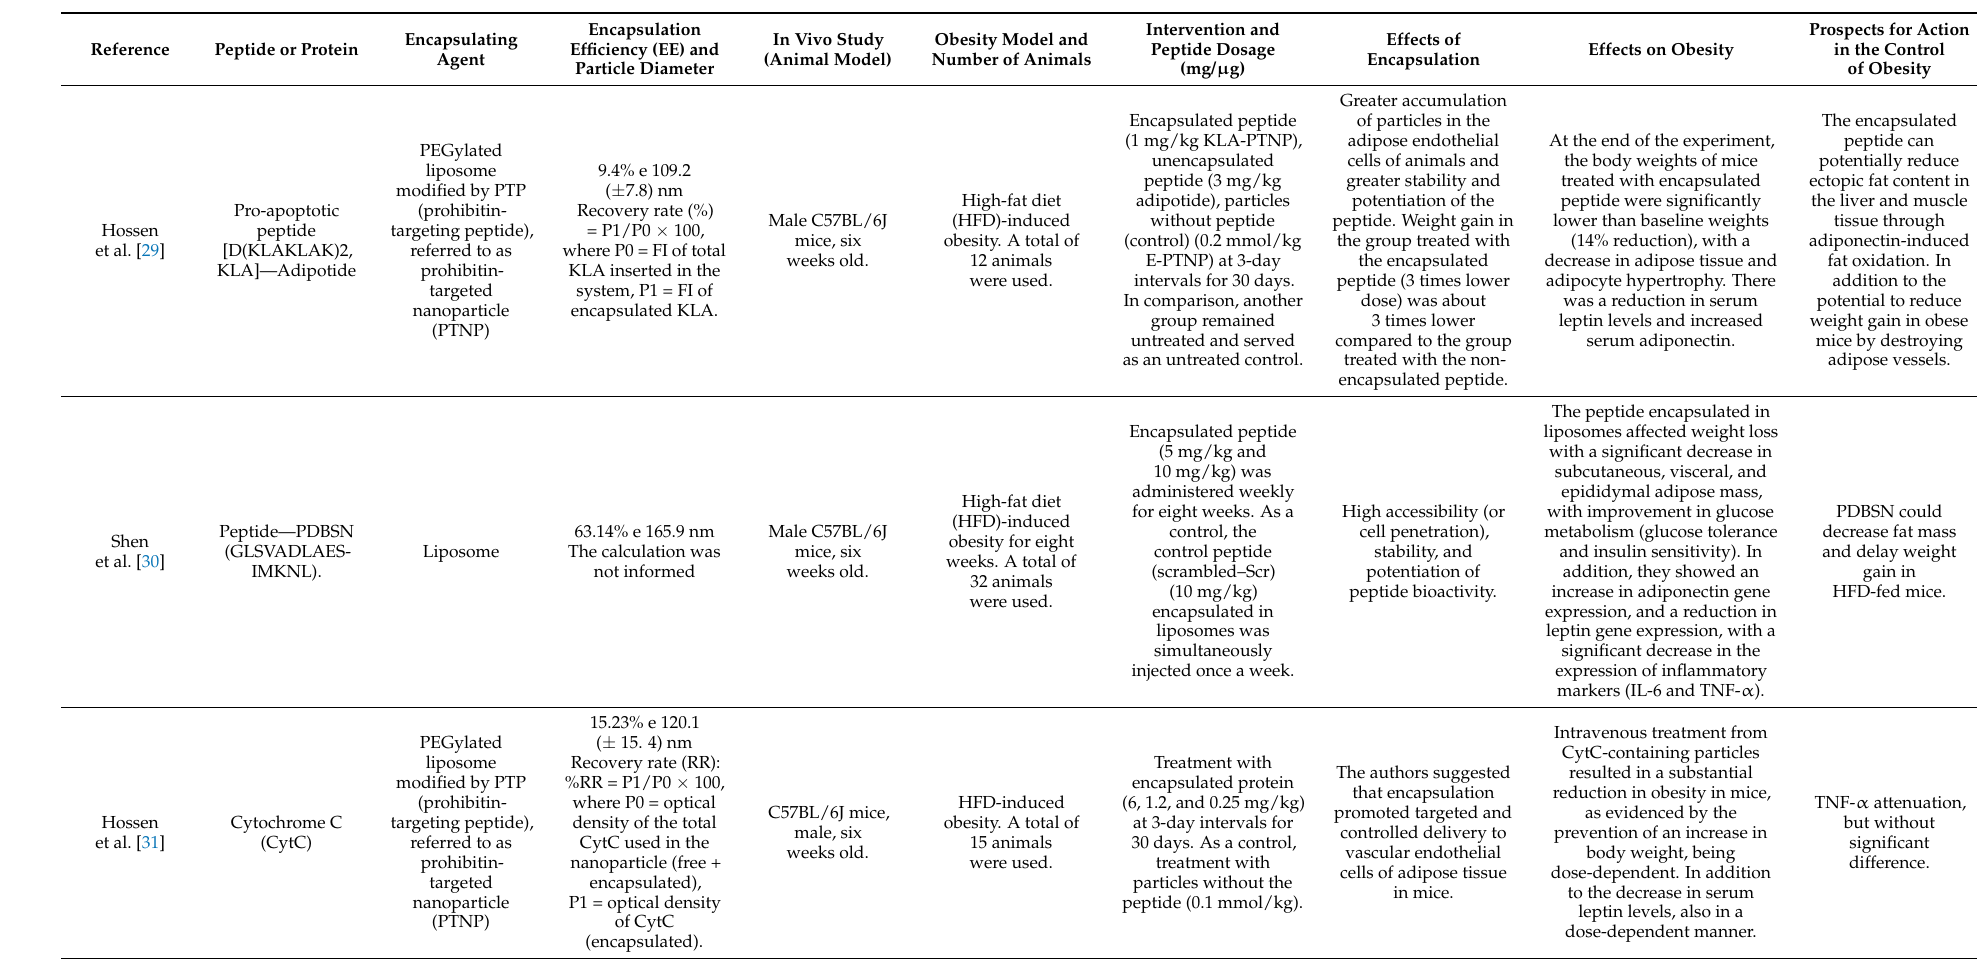
Table 1. Characterization of studies carried out with encapsulated peptides or proteins with effects on weight loss in experimental